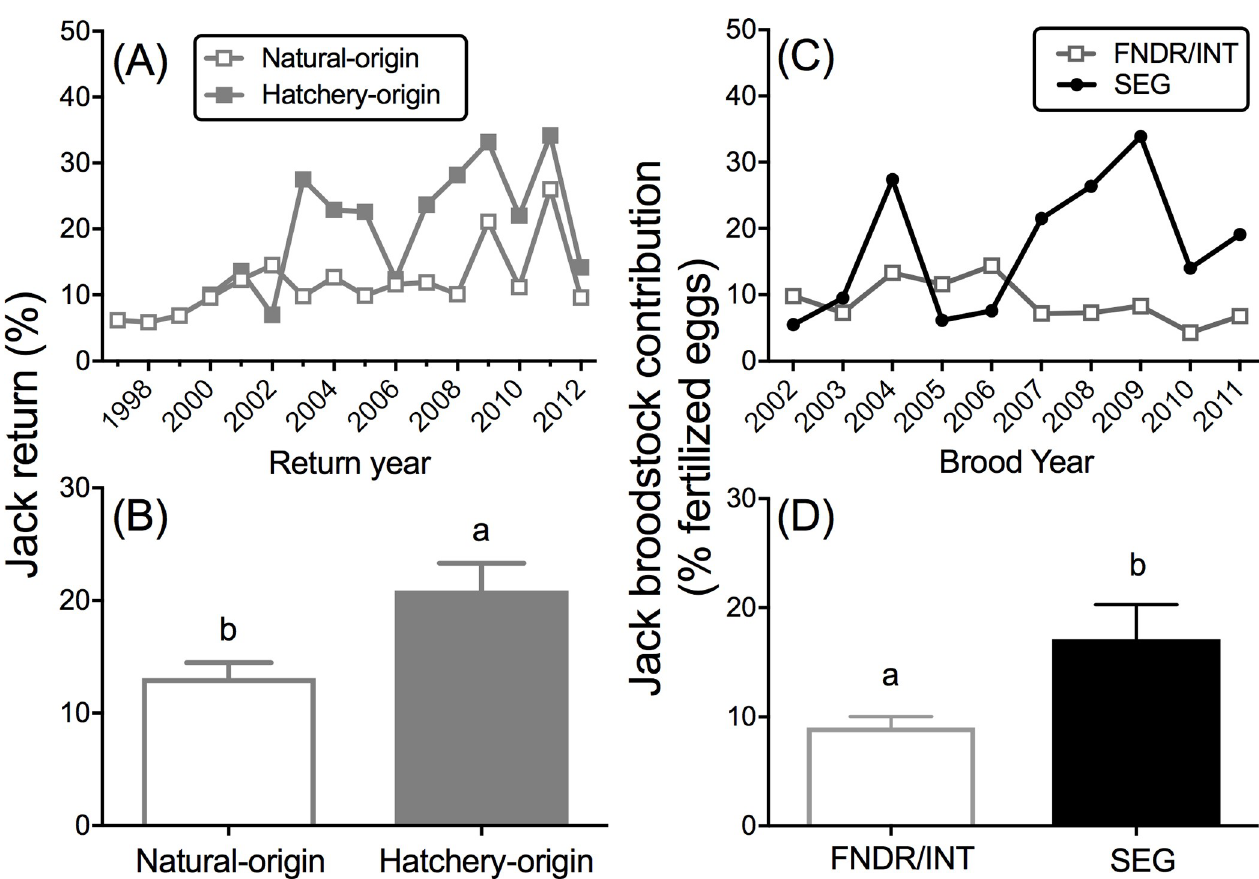
Fig 7. Age-3 jack return rates and contribution to hatchery broodstock. ( A ) The percent of natural- and hatchery-origin age-3 jacks (among males and females) that returned to RAMF during 1997–2012 (among their release cohort, age 4 and age 5 fish returned in the following years) and (B) averaged over return years 2000–2012. (C) The estimated percentage of eggs fertilized by age-3 jack males from the natural-origin (FNDR, INT) and hatchery-origin (SEG) broodstock during BYs 2002–2011 at CESRF and (D) averaged over BYs 2002–2011. Different letters within figure represent statistical differences, α = 0.05.